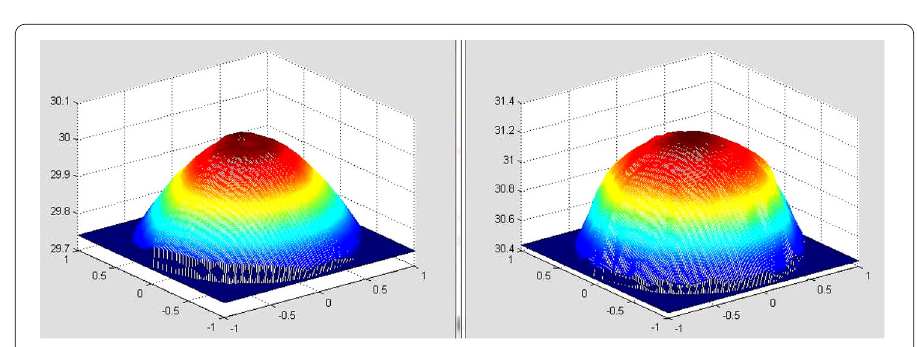
Figure 7 The surfaces ( f on the left and g on the right) of the beam shaping